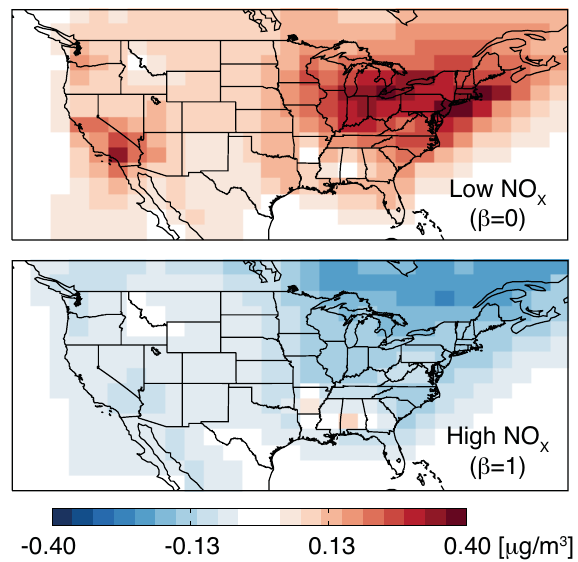
Fig. 6. The change in surface concentration of total OA (August 2000) compared to concentrations in Fig. 5 as a result of forcing photooxidation and ozonolysis through either the low-NO x ( β =0) or high-NO x ( β =1) yields. POA is assumed to be non-volatile and IVOCs do not form aerosol (traditional simulation).